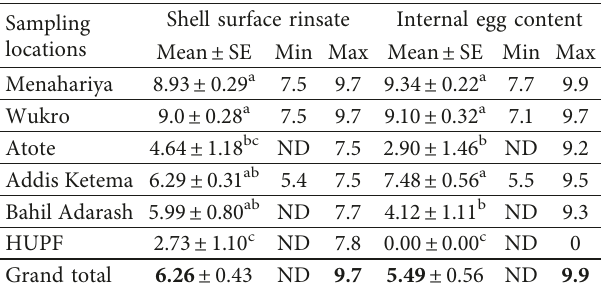
Table 9: Yeast and mold count (YMC) in log surface rinsates and contents of egg samples in Hawassa City, southern Ethiopia, 2019.